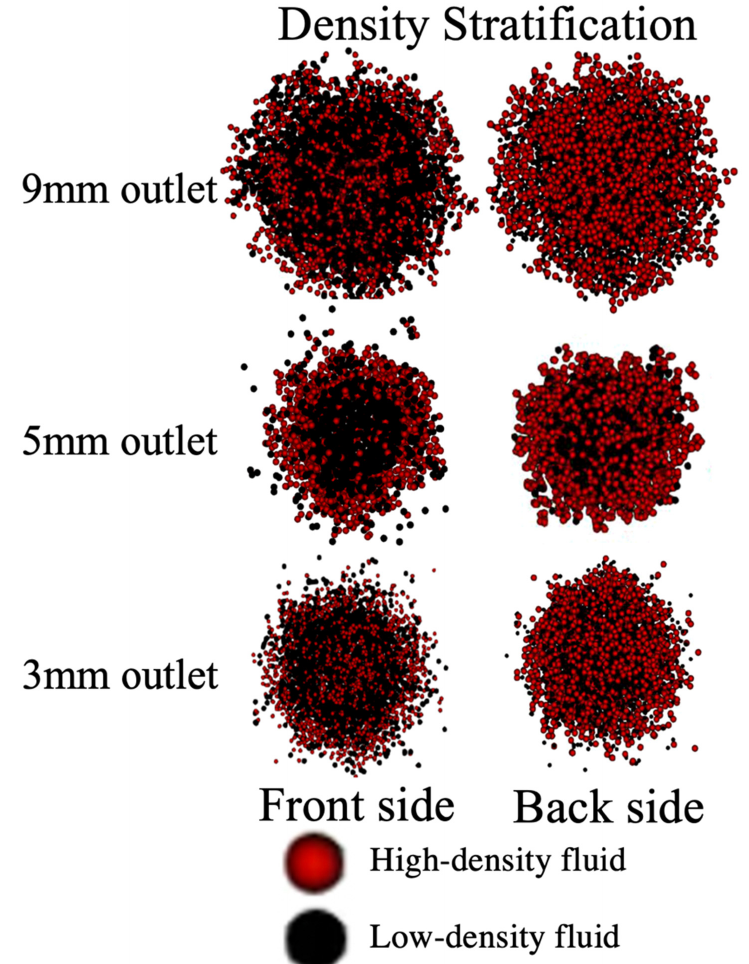
Figure 11. Summary of the material distributions after the solidification with different outlet in the case of the density stratification.